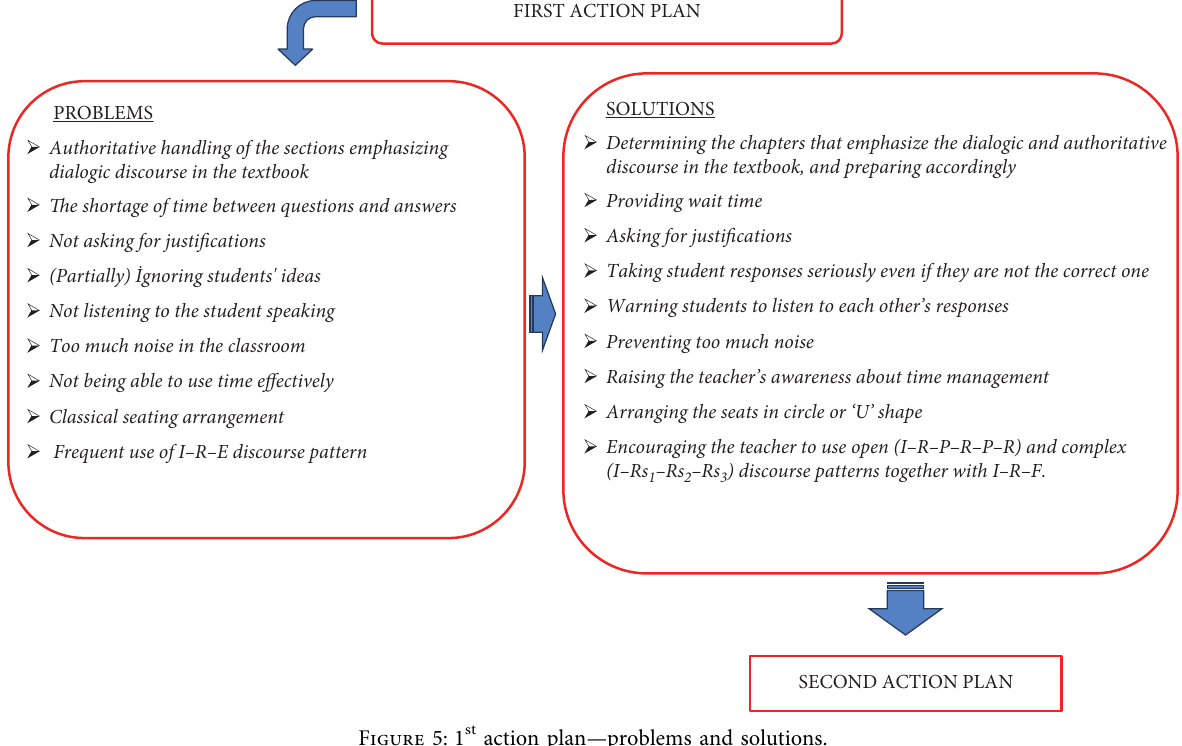
Figure 5: 1 st action plan—problems and solutions.